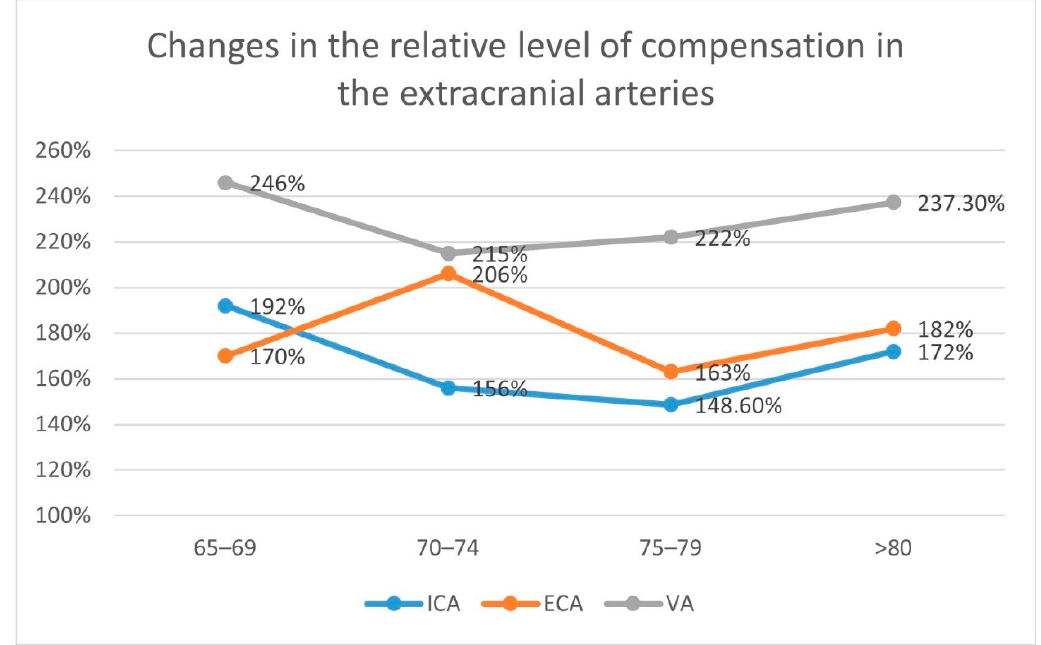
Figure 2. Changes in the relative level of compensation in extracranial arteries in patients with ICA occlusion. No significant increasing or decreasing tendencies or correlations concerning the level of compensation were observed in the ICA, ECA, and VA. Table 4. The level of compensation in all extracranial arteries. ICA occlusion are presented in Table 5, and with bilateral ICA occlusion in Table 6. Table 5. Pathways of collateral circulation in patients with unilateral ICA occlusion.